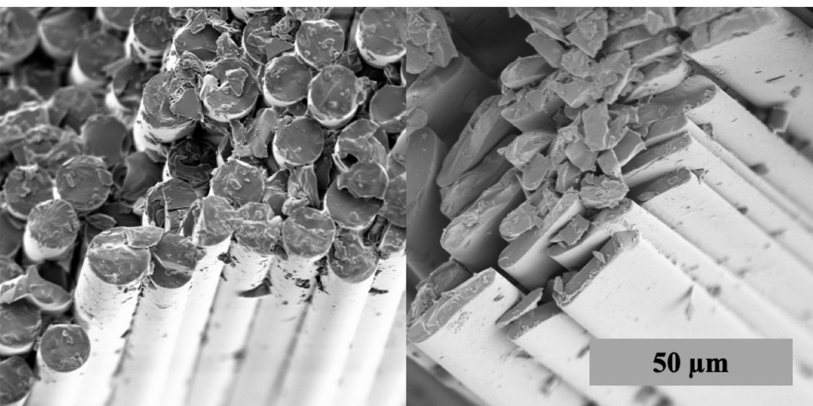
Figure 1. SEM of circular and flat cross-section glass